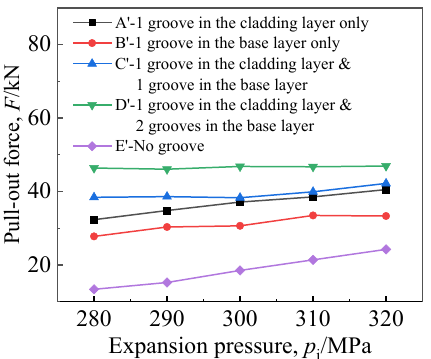
Figure 12. Effect of groove location on pullout force.